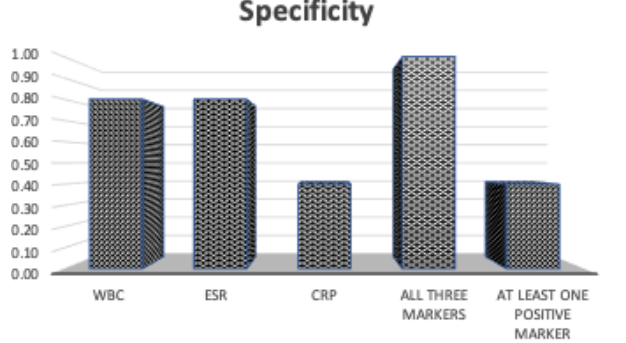
Figure 3. Specificity for true abscess when either WBC, ESR, CRP, all three markers, or at least one marker were positive. In order, the specificities were 0.80, 0.80, 0.40, 1.00, and 0.40.